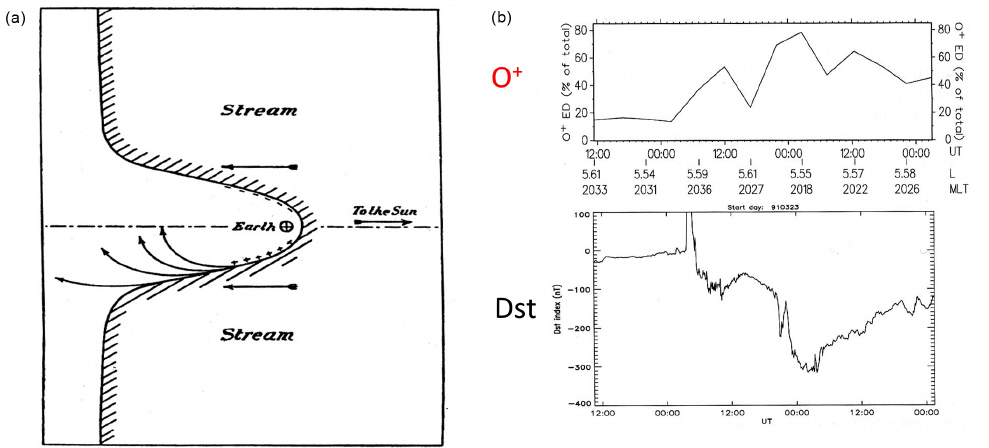
Figure 7. (a) Chapman considered that there occurs a charge separation on the magnetopause and the released particles circulate around the earth, forming the ring current (Chapman and Bartels, 1940: p. 868, Fig. 5). (b) Time variations of the flux of singly ionized oxygen ions and the D st storm index (Daglis,